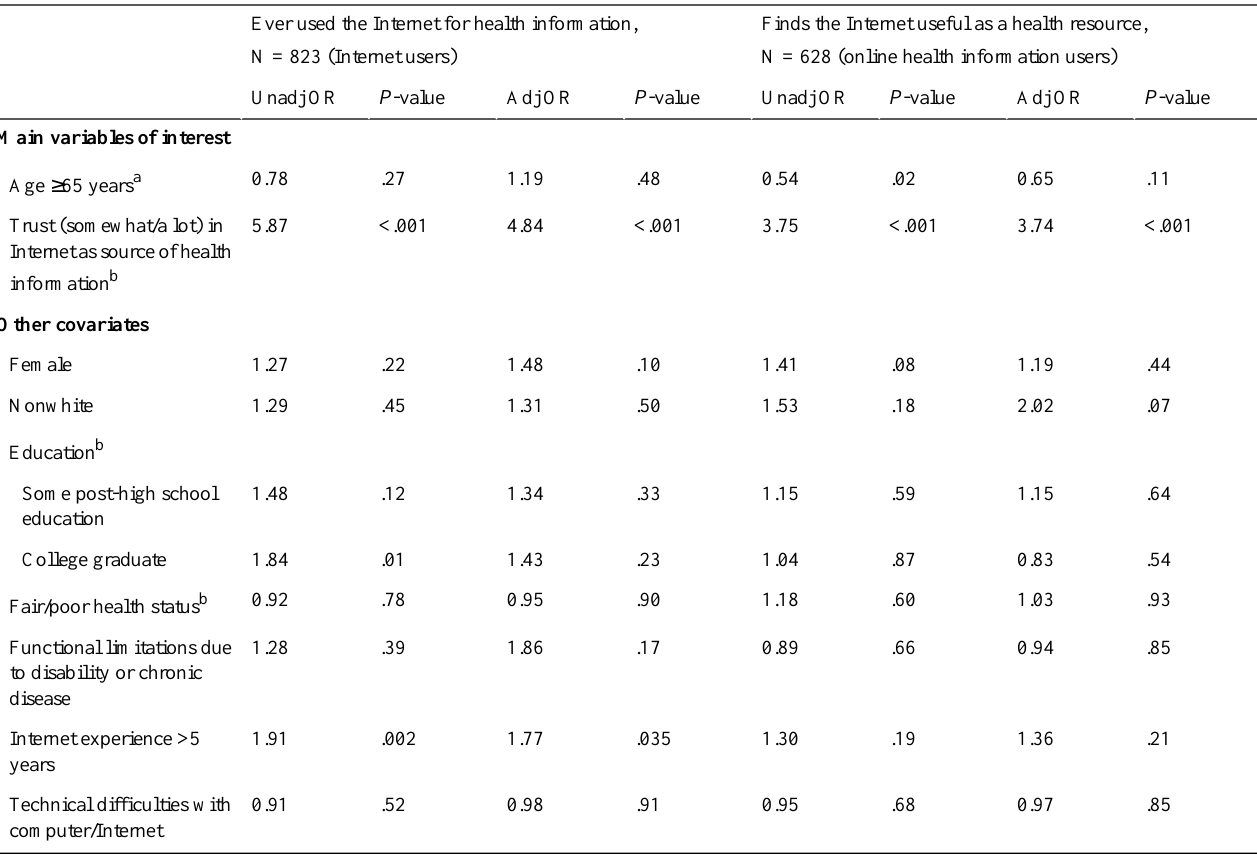
Table 2. Characteristics associated with a person using the Internet for health information and finding the Internet useful as a health resource Finds the Internet useful as a health resource, users)Ever used the Internet for health N = 628 (online health information